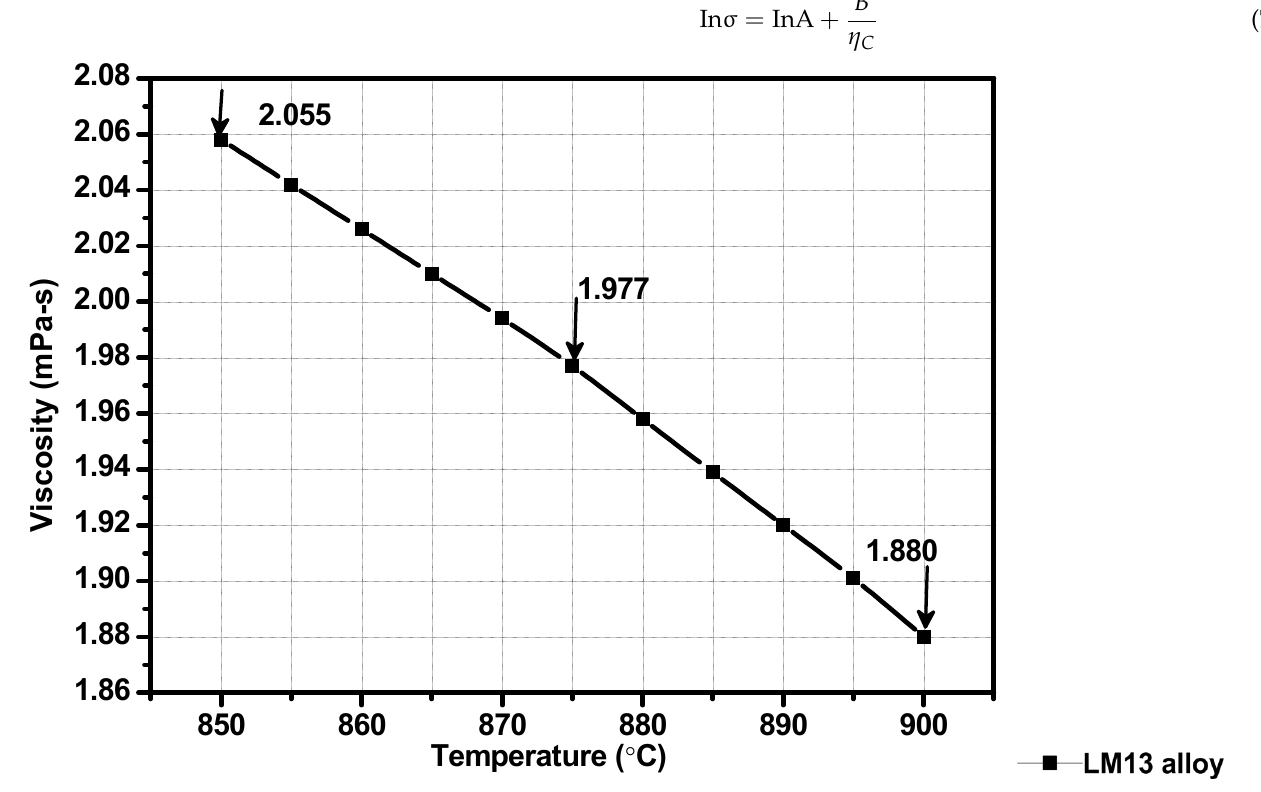
Figure 6. The e ff ect of foaming temperature on the viscosity of the LM13 alloy and composite foams. For example, in A and B, the substance-dependent constants are σ and η C , respec- tively. With the help of Equation, we discovered a connection between surface tension and viscosity (7). For this reason, we modi fi ed Equation (7) to fi nd the data’s correct value. Figure 7 depicts the functional relationship between surface tension and composite foam temperature using Equation (7).